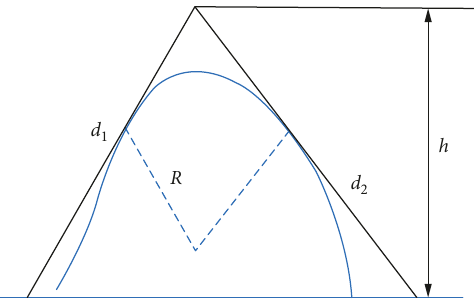
Figure 7: Schematic diagram of each distance parameter